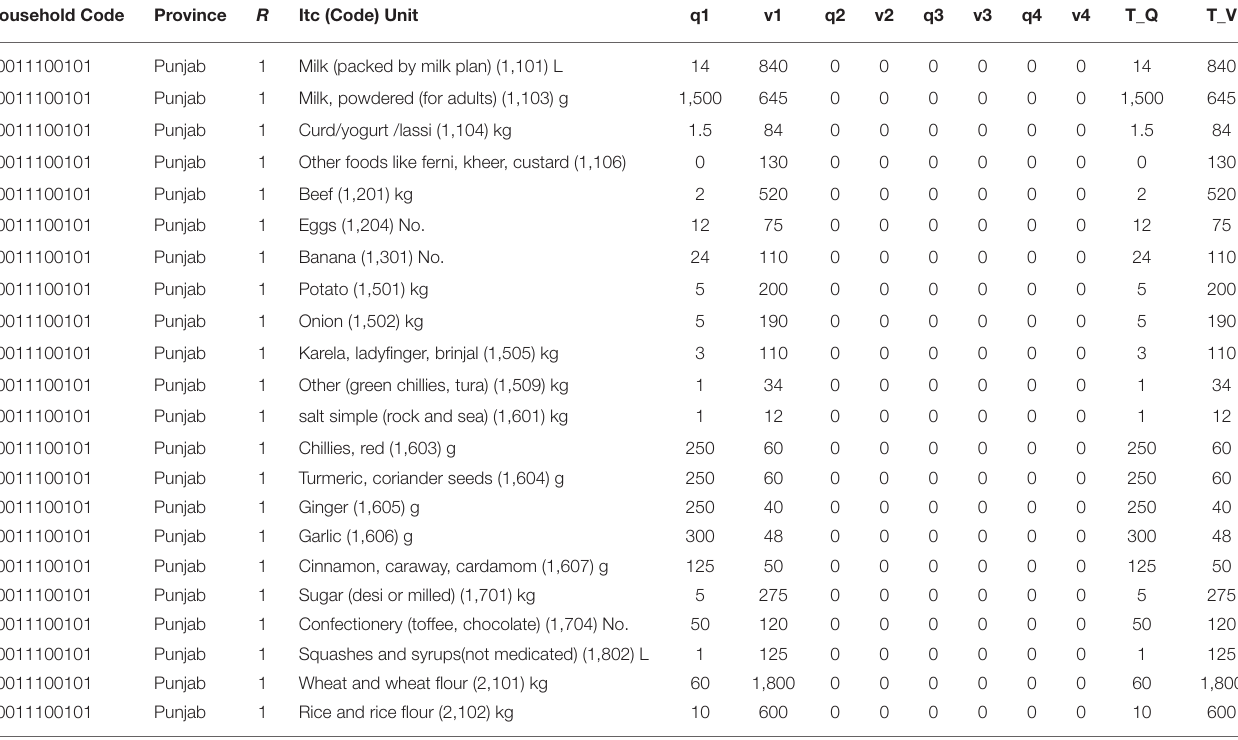
TABLE 3 | Item-wise food consumption profile of a household in Household Integrated Economic Survey (HIES) consumption module. Household